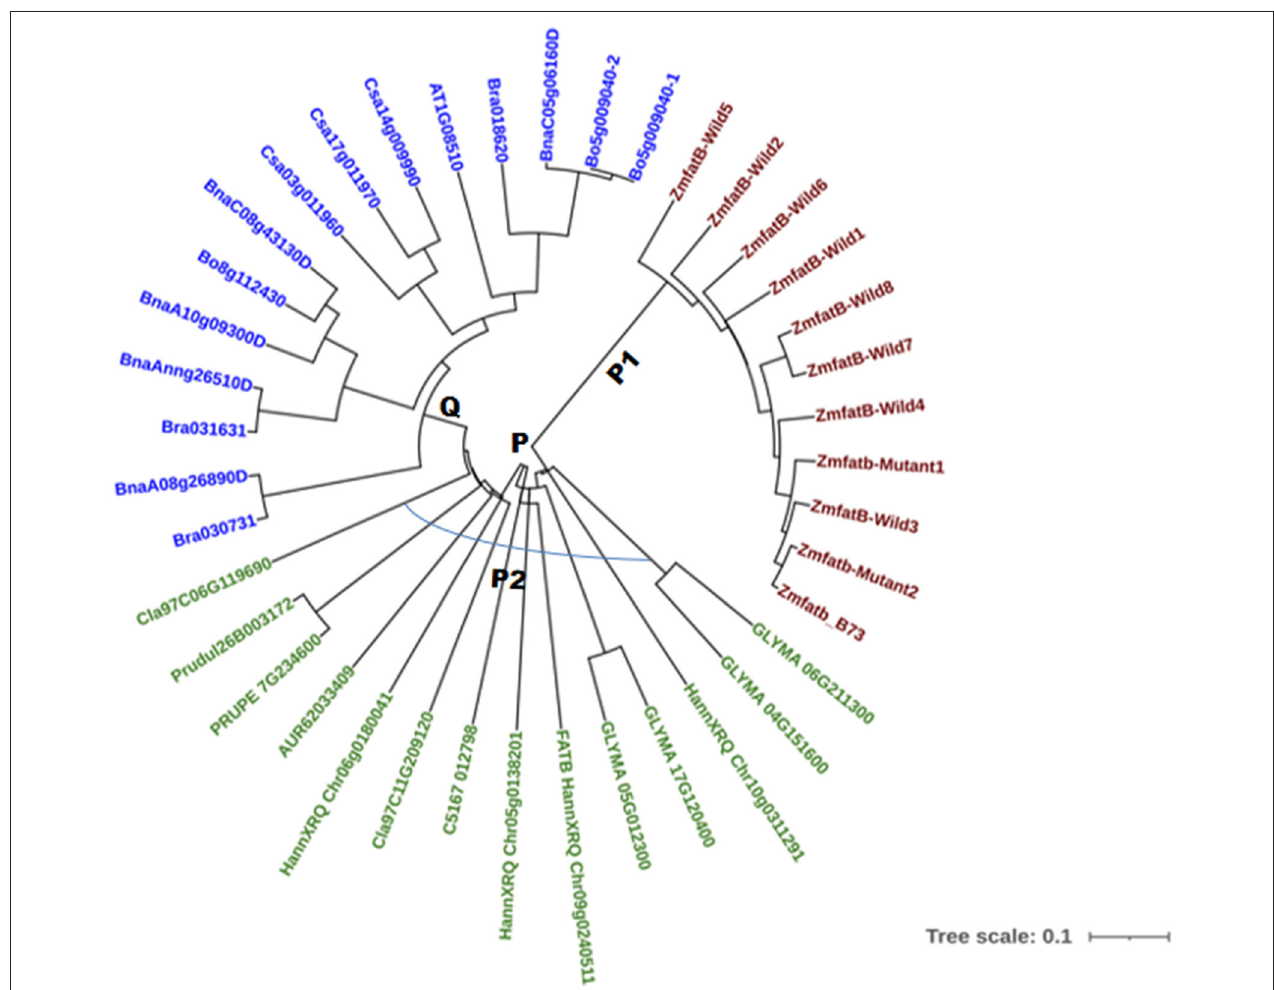
FIGURE 4 | Nucleotide based phylogenetic tree of maize and its orthologue